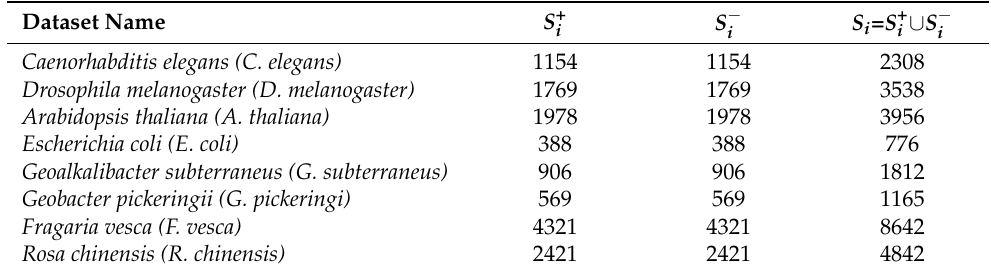
Table 2. The number of positive and negative samples collected from each of the eight